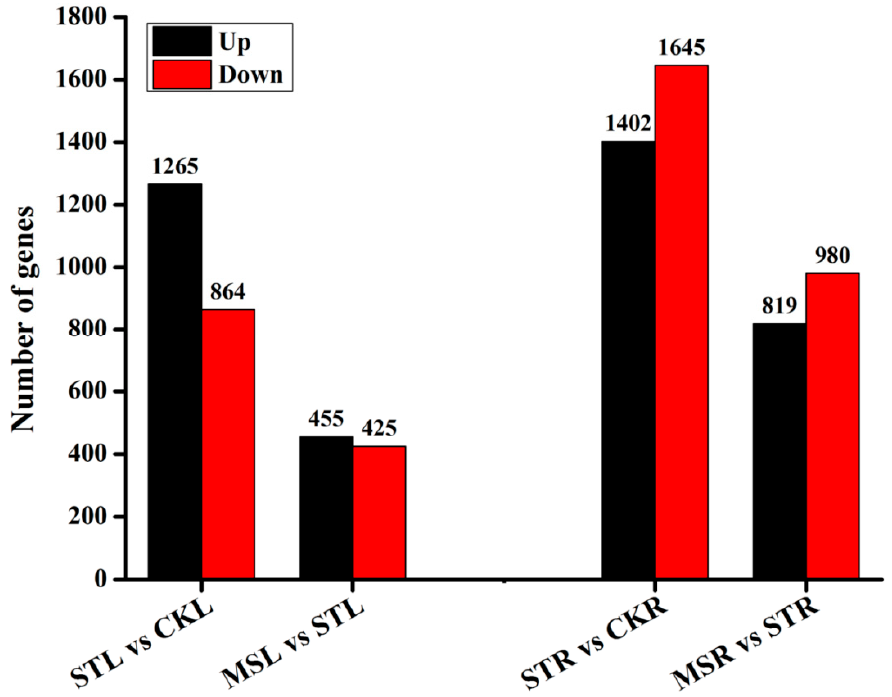
Figure 3. Number of regulated genes in the different comparisons. STL = leaves in ST treatment; CKL = leaves in CK treatment; MSL = leaves in MS treatment; STR = roots in ST treatment; CKR = roots in CK treatment; MSR = roots in MS treatment. The Arabic numbers on the column are the genes numbers of different comparison of leaves/roots between treatments.